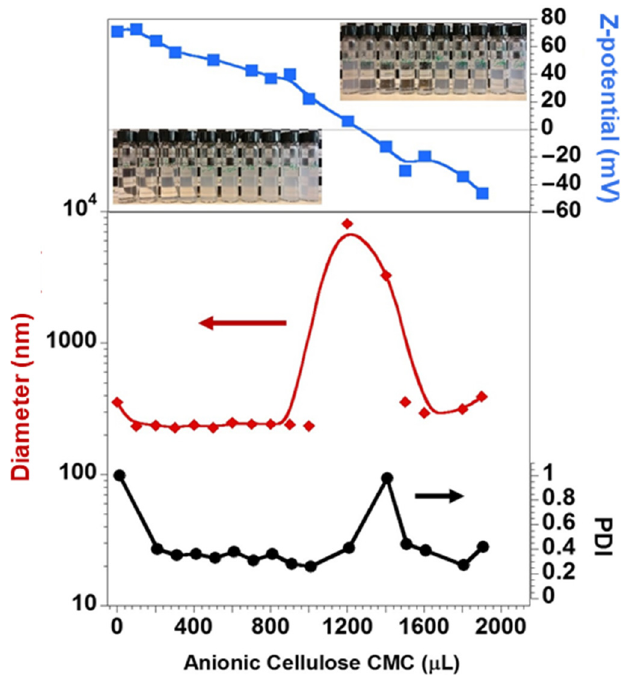
Figure 2. Changes of the average size, PDI, and ζ -potential of the DDAB vesicles upon the progressive addition of CMC. The average values are reported with a relative standard deviation lower than 3%. The inserted photos show the evolution of turbidity of the samples with CMC addition. Lines are just guides for the eyes.